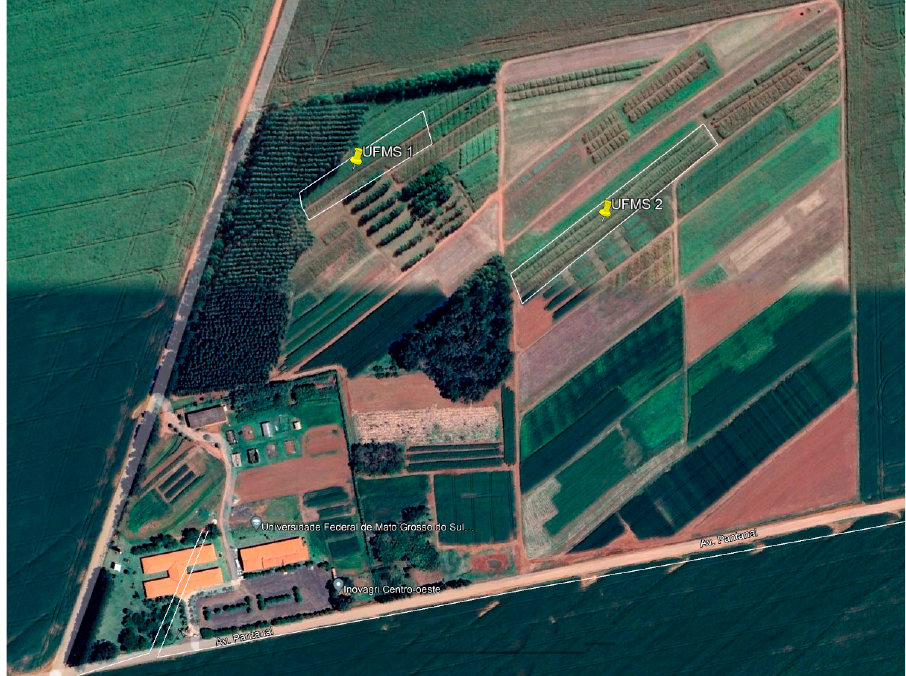
Figure 3. Location of the two experimental trials conducted in the agricultural production areas named UFMS 1 and UFMS 2 in Chapadão do Sul, MS, Brazil, during the 2019 off ‐ season. The treatments were arranged as a split ‐ split plot in a randomized complete block design with four replicates. The main plots consisted of two production systems (agricul ‐ tural area with (agroforestry system—UFMS 1) and without (traditional system—UFMS 2) direct effect of the eucalyptus forest). The subplots consisted of intercropped and non ‐ intercropped corn with ruzigrass. The subsubplots were represented by the cultivation of two corn hybrids (NS50 RR2 PRO PRO2 (simples hybrid, super early cycle of 130–142 days and high yield potential) and INVICTUS VIP3 (simples hybrid, early cycle of 140–150 days and high yield potential)). The trial units (subplot) comprized seven corn rows, with 0.45 m interrow spacing and 5 m in length (15.75 m 2 ). The utility area comprized the five central rows of each subplot, ignoring 0.5 m from each edge (i.e., 9.0 m 2 ). The corn crop was mechanically sown on 8 February 2019, at a depth of 3.0 cm in rows of 0.45 m and a density of 3 seeds per meter to reach a final stand of 55,000 to 60,000 plants per hectare [30]. Corn seeds were previously treated with 150 g kg − 1 imida- cloprid and 450 g kg − 1 thiodicarb [30]. Corn fertilization was carried out as recommended by [27]. Fertilization was carried out by applying 104 kg ha − 1 of P 2 O 5 and 22 kg ha − 1 of N (monoammonium phosphate—MAP) at sowing. At 35 days after emergence—DAE (V 5 stage—five fully expanded leaves), 120 kg ha − 1 of N (urea) and 90 kg ha − 1 of K 2 O